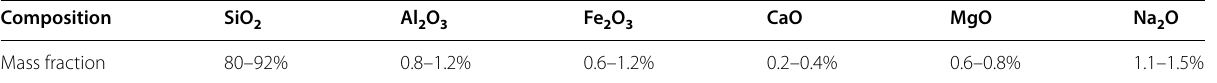
Table 3 Common ranges of chemical compositions of silica fume used in China.